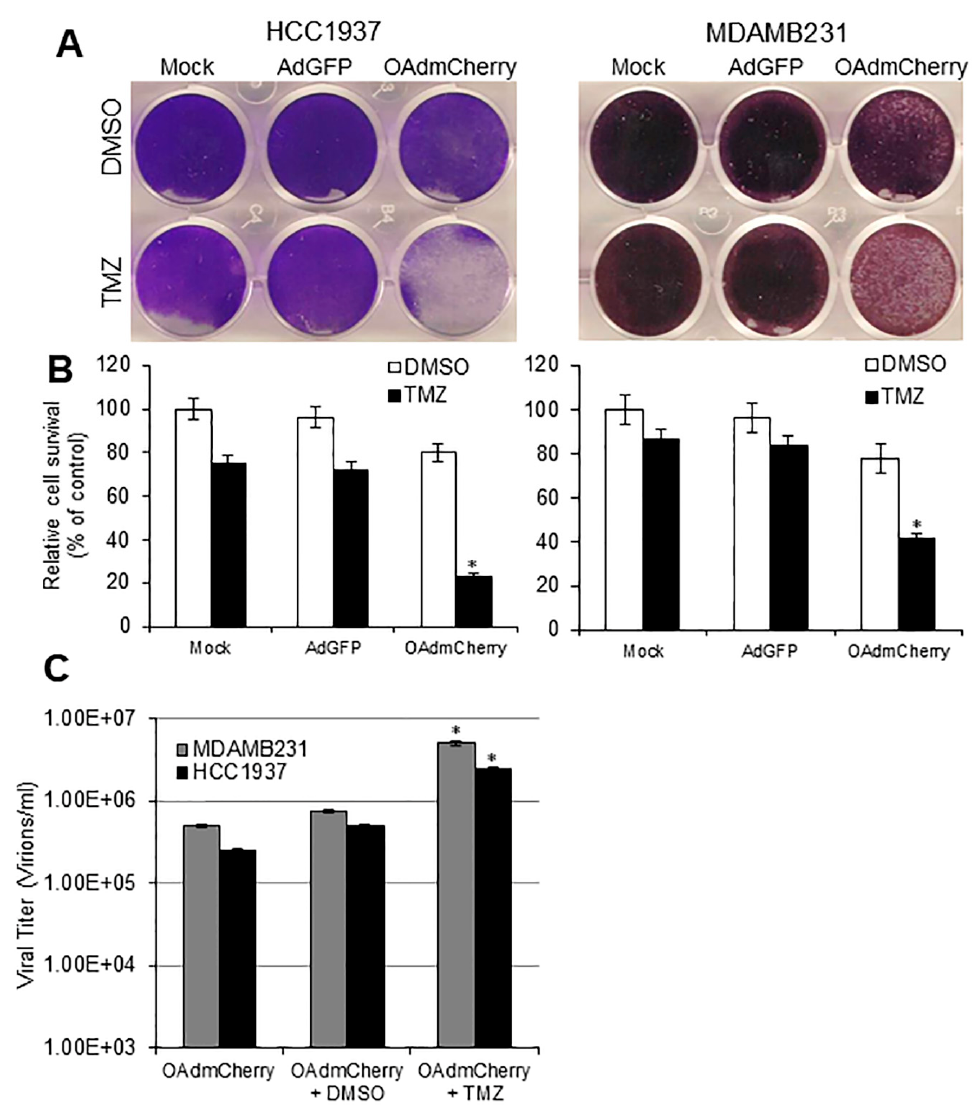
Figure 4. Temozolomide (TMZ) enhances oncolytic adenovirus (OAd)-mediated cytopathic effect (CPE) through increased viral replication: ( A ) Human triple-negative breast cancer (TNBC) cells were infected with OAdmCherry or adenovirus expressing green fluorescent protein (AdGFP) at a multiplicity of infection concentration of 2.5 alone or in combination with either dimethyl sulfoxide (DMSO) or TMZ. At 72 h post infection, crystal violet staining was used to evaluate CPE. A representative staining is shown of three experiments performed. ( B ) OAd-mediated CPE was calculated by measuring the absorbance of solubilized dye at 590 nm. Results represent the mean of three repeated measurements ± standard deviation (SD; error bars) (* p < 0.05). ( C ) Supernatants were collected and used to determine adenovirus yield from each cell line. Results represent the mean of three repeated measurements ± standard deviation (SD; error bars) (* p < 0.05).